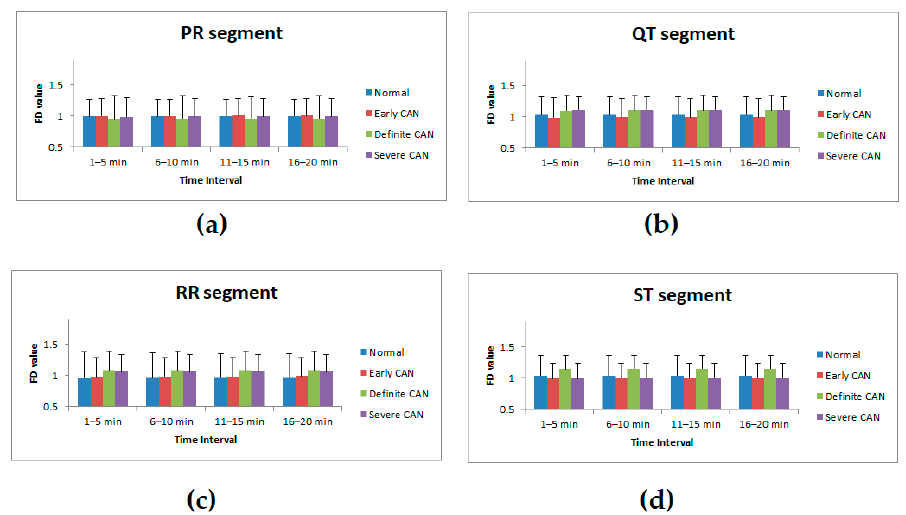
Figure 8. Mean and SD value of FD after each 5 min interval of all groups of ( a ) PR segment, ( b ) QT segment, ( c ) RR segment, and ( d ) ST segment.